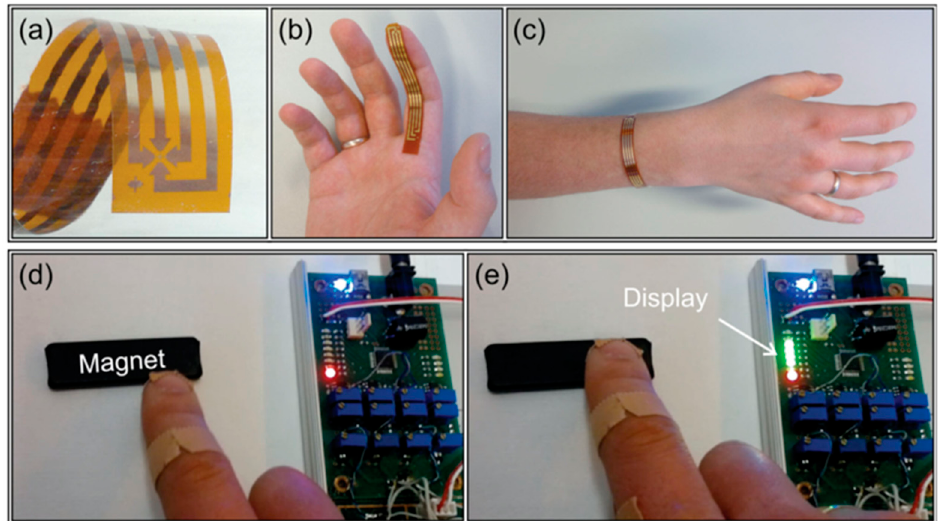
Figure 20. Flexible Hall sensor attached to the human body for interactive pointing devices. ( a ) Magnified view of the flexible Hall sensor; ( b , c ) Flexible Hall sensor attached to the human body; ( d , e ) The relative position of the finger with respect to a permanent magnet is displayed in real time by monitoring the sensor output. Adapted with permission from Ref. [18]. Copyright 2015, copyright John Wiley & Sons, Inc.